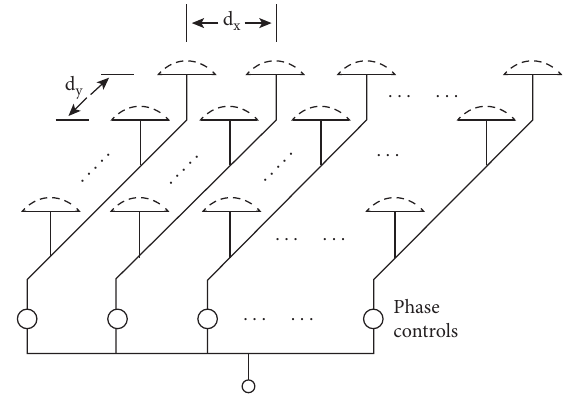
Figure 1: Planar array antenna diagram